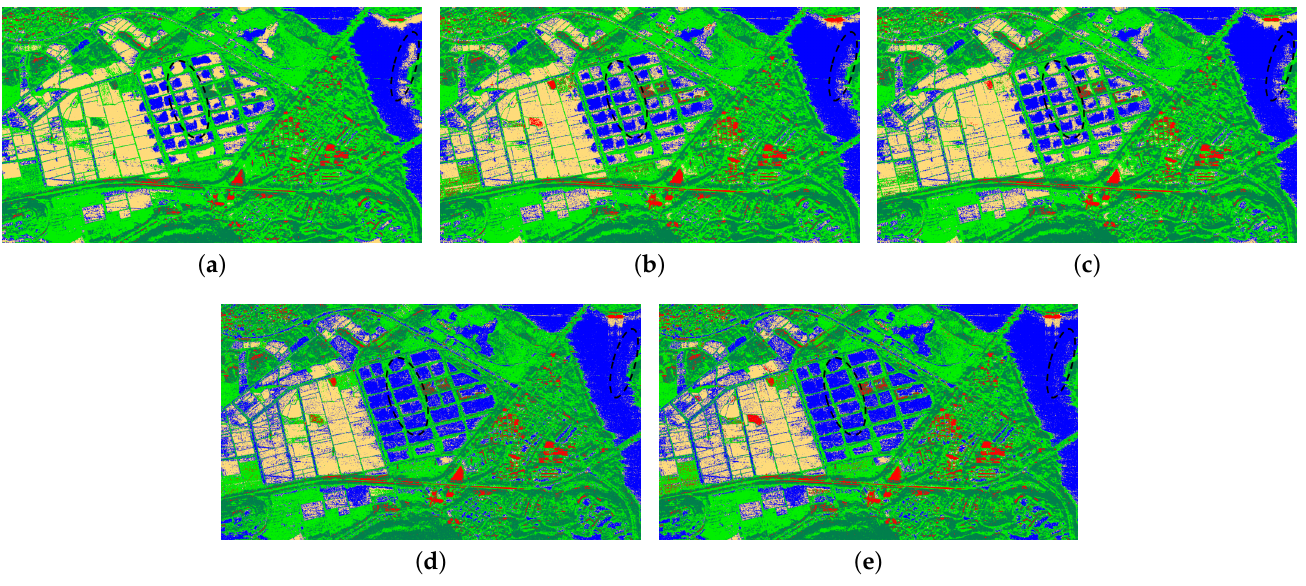
Figure 6. The ML-based classification maps of five models on the Boao region. ( a ) Wishart. ( b ) K- Wishart. ( c ) G. ( d ) WMM. ( e )